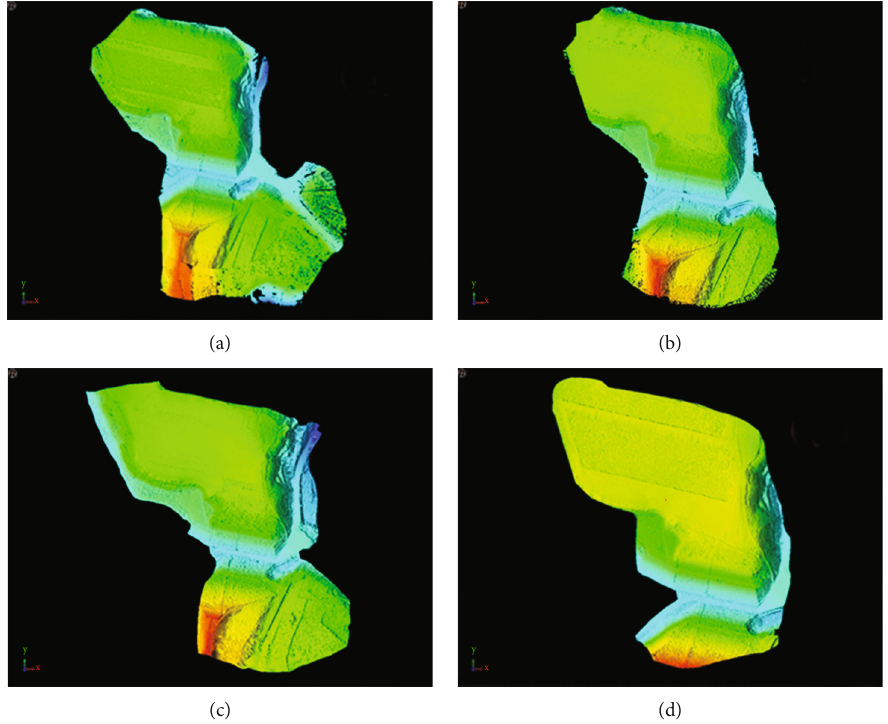
Figure 7: DEM model diagram of phase I to phase